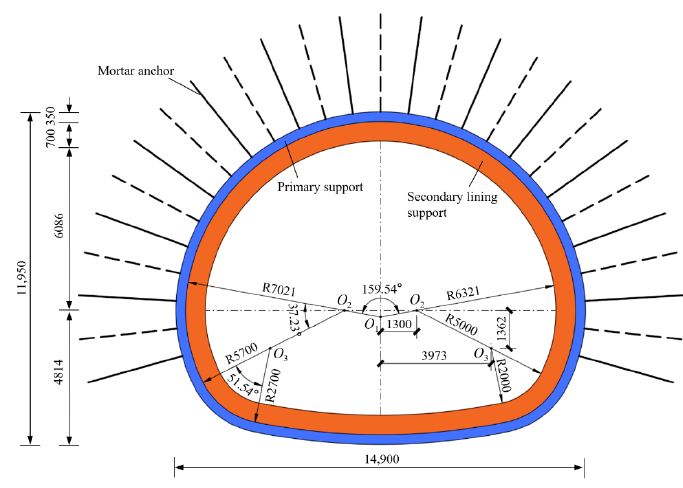
Figure 3. Design drawing of the support scheme (mm).